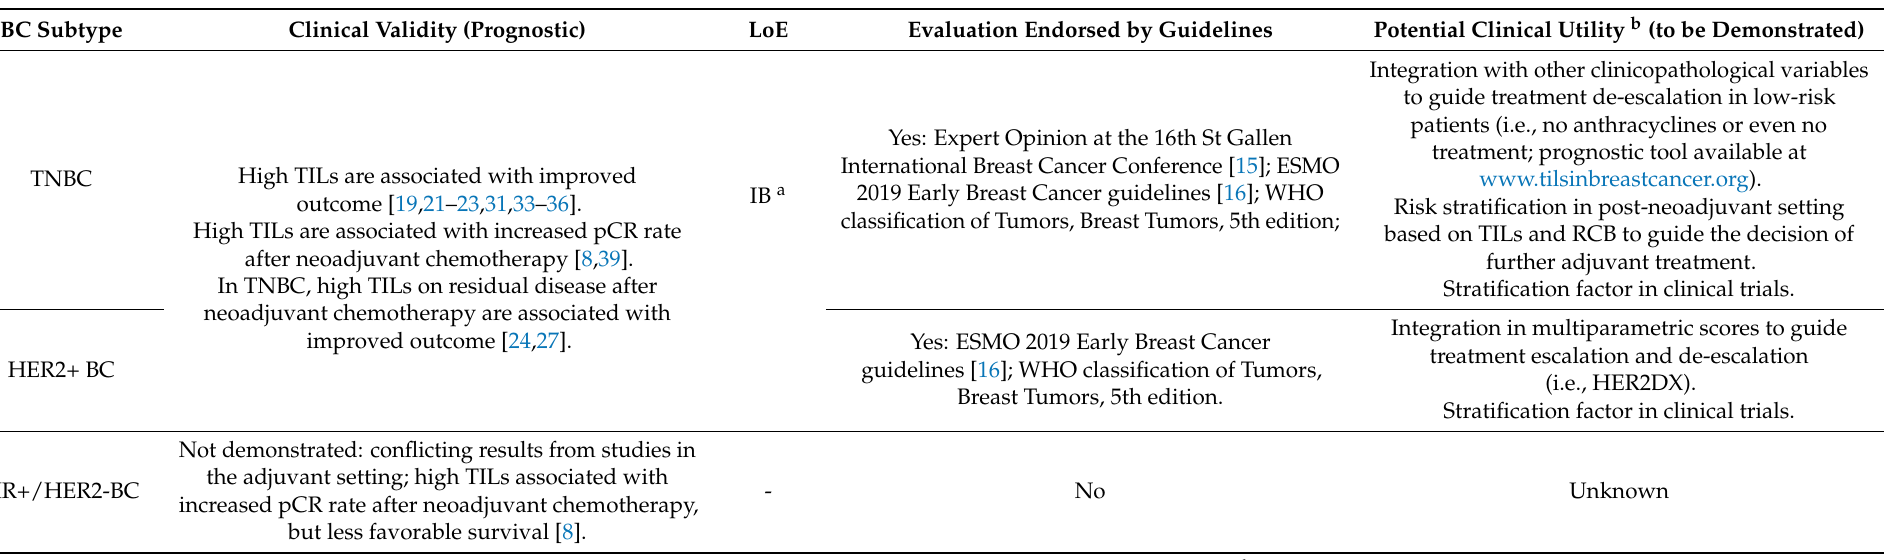
Table 4. Summary of clinical validity of TILs as a prognostic marker and potential clinical utility in patients with early breast